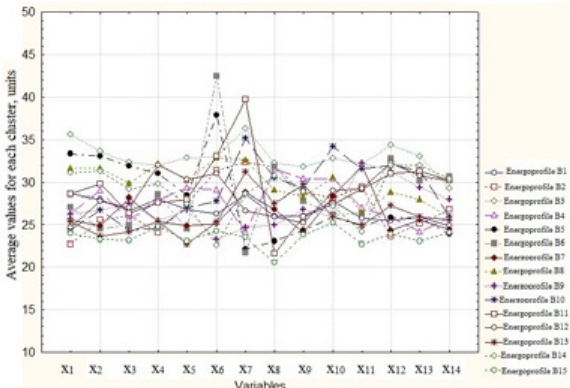
Fig. 2: Energy profiles of 15 KNUTD buildings; graph of average values for 14 indicators (STATISTICA 10 listing)